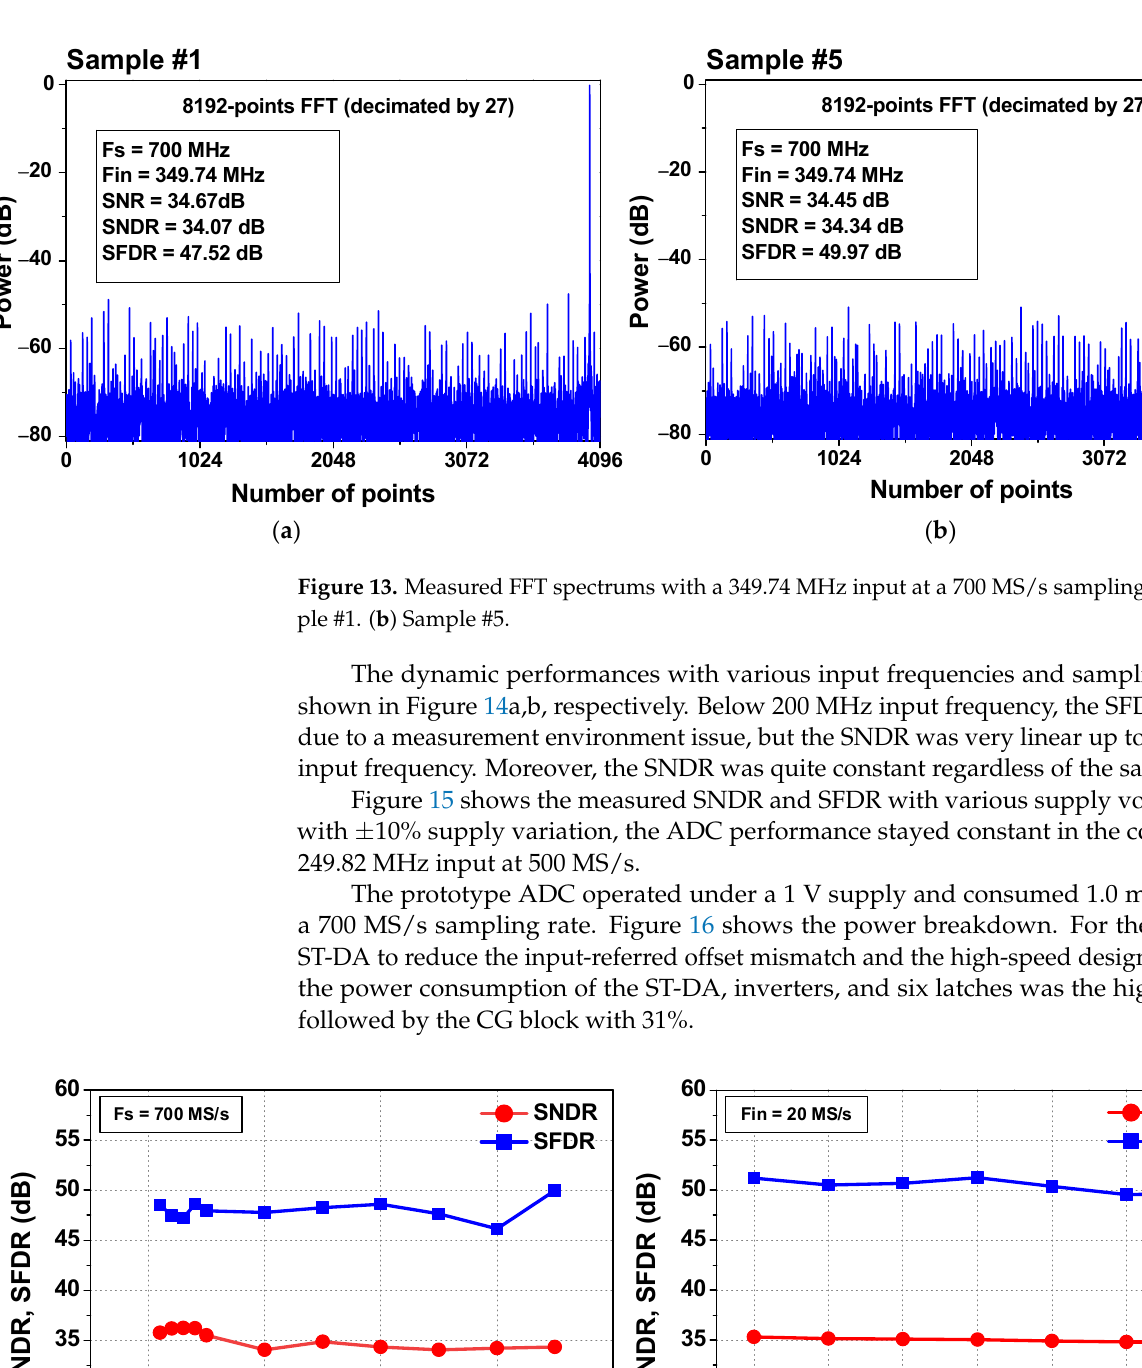
Sample Number Figure 12. Measured SNDR and SFDR from five different samples near Nyquist input at 700 MS/s.